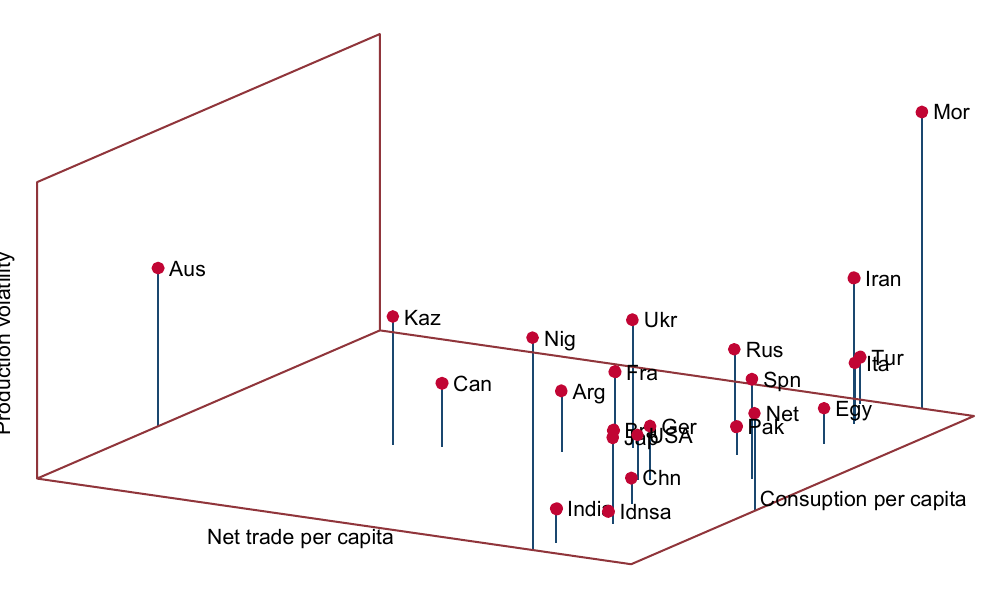
Figure 7. Production volatility, consumption and trade per capita, 2012.